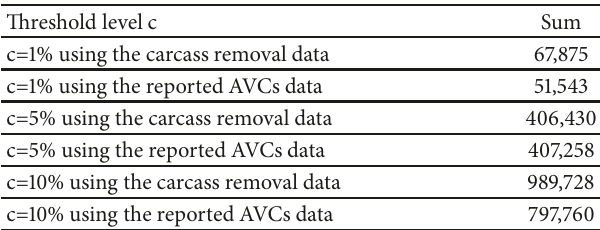
Table 9: Thetotalranking differenceof the hotspotsidentified using the carcass removal data and the reported AVCs